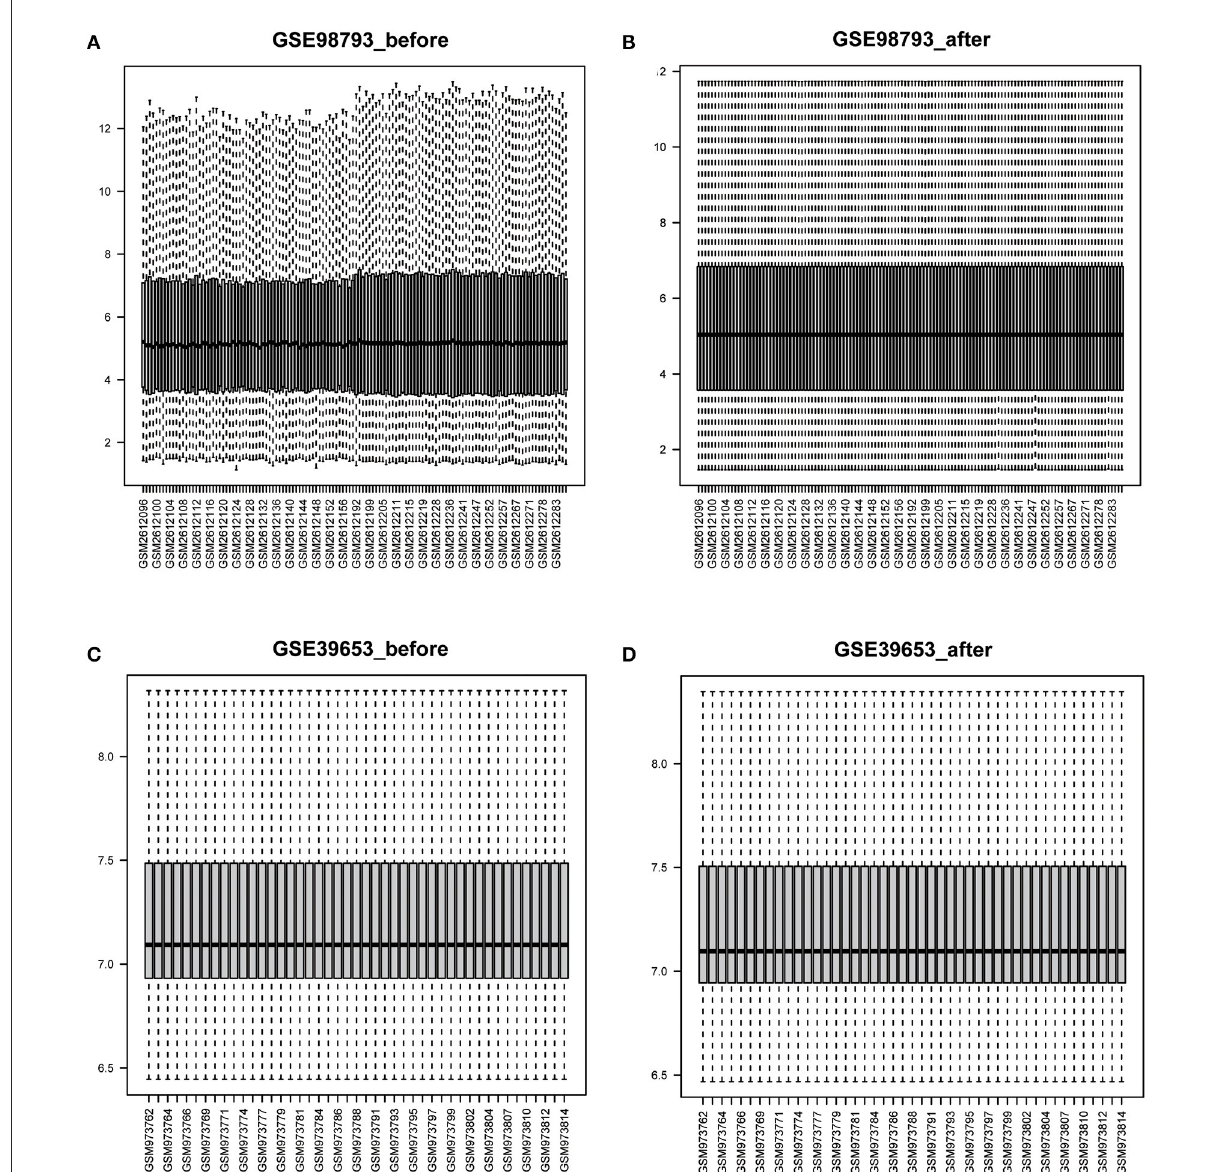
FIGURE2 Boxplots of the gene expression data before and after normalization. (A) The boxplot of GSE98793 data before normalization. (B) The boxplot of GSE98793 data after normalization. (C) The boxplot of GSE39653 data before normalization. (D) The boxplot of GSE39653 data after